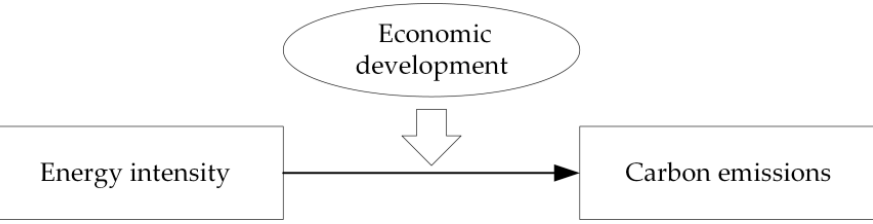
Figure 6. Moderating effects of economic development on energy intensity and carbon emissions. The preceding analysis shows that economic factors contribute to improving the impact of EI on CE. To further identify the potential non-linear moderating effect of economic factors, Equation (10) is used to analyse the threshold effect. Table 8 shows the test results, suggesting that economic development exceeds the simple threshold at a significance level of 0.10, and the corresponding threshold is 2.7868. The double and triple thresholds are not significant, indicating that economic factors have a non-linear effect on the simple threshold to reduce CE by EI. When the economic development level is below the simple threshold, the regression coefficient of EI is 0.2152 at a significance level of 0.10, indicating that a 1% reduction in EI leads to a 0.2152% reduction in CE. When the economic level is above the critical value, a 1% reduction in EI leads to a 0.3003% reduction in CE. Therefore, the reduction of CE by EI is more effective in regions with a higher level of economic development. From Sections 4.1 and 4.2, economic development has a facilitating effect on CE. However, considering that the inhibiting effect of EI on CE is much higher than the promoting effect of economic development, it can be concluded that promoting economic development and lowering EI is an effective way to reduce CE. Analysis of regional economic development level data shows that only the economic development level of Xicheng District exceeds the threshold of 2.7868 from 2010 to 2012. The economy of Dongcheng District develops rapidly and exceeds the critical value of 2.7868 in 2013, and the economic development level of Haidian and Chaoyang districts exceeds